Question: State the chart type depicted above.
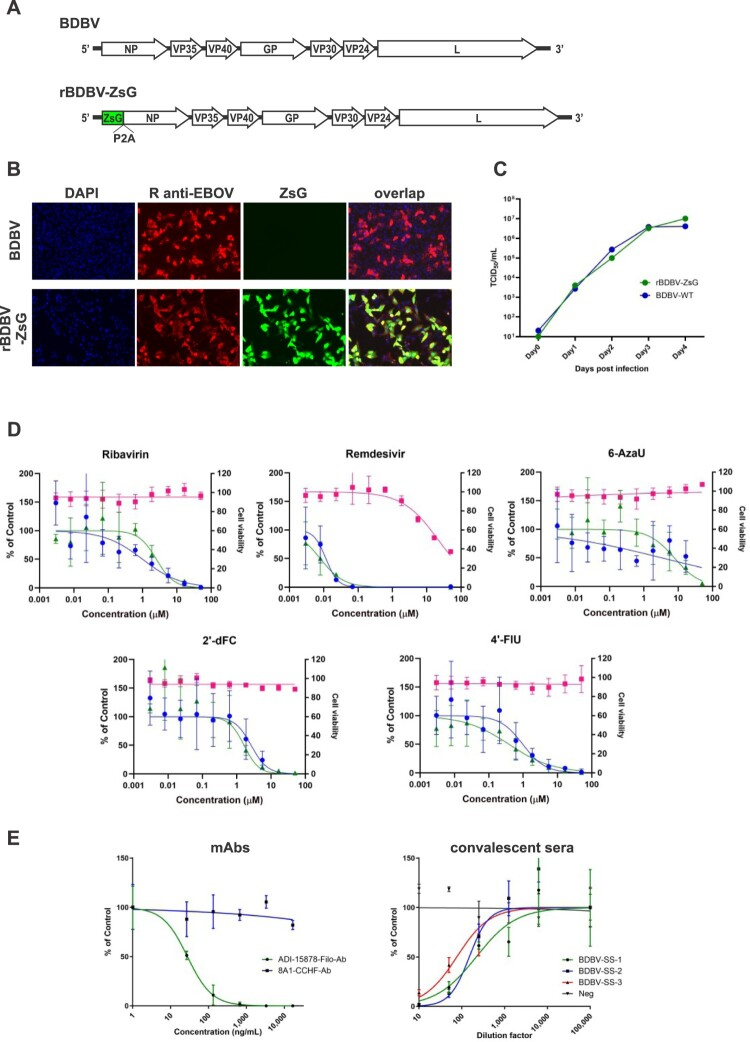
Answer: line